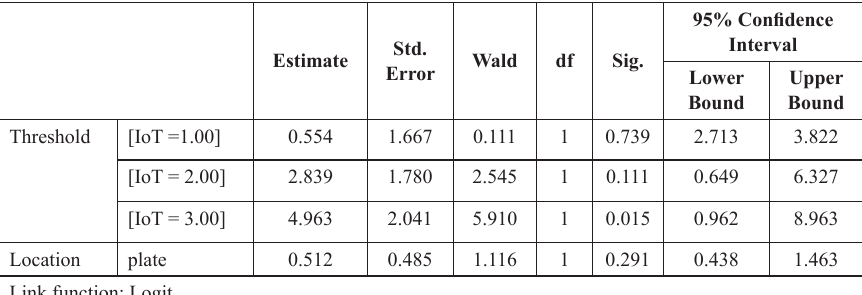
Table 7. The parameter estimates for academic